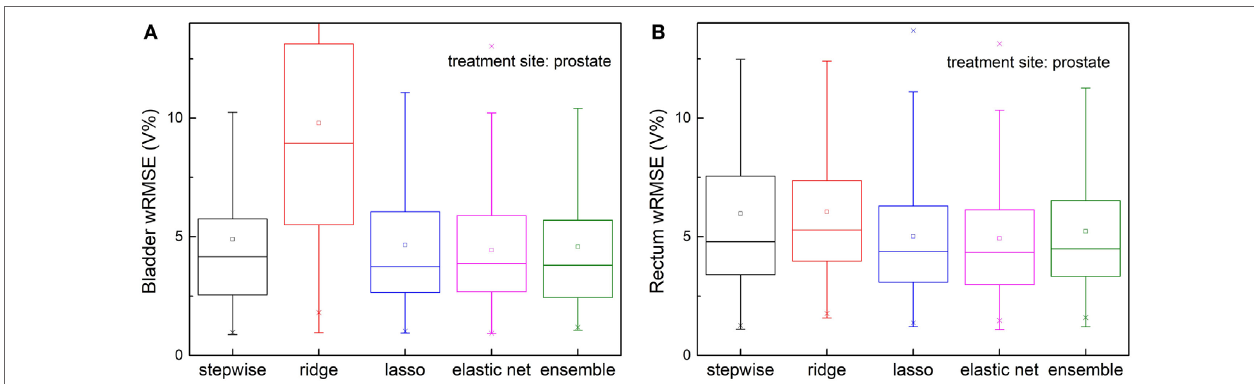
FigUre 4 | Prediction errors [weighted root mean squared error (wRMSE)] of individual regression models and the proposed ensemble model for (a) bladder (B) rectum. The training set and validation set for all the models tested are identical. Twenty prostate 1PTV cases are included in training set, and the validation set includes 146 cases. For bladder prediction, the proposed ensemble method predicts significantly better than stepwise ( p < 0.001), ridge ( p < 0.001), lasso ( p < 0.001), and elastic net ( p < 0.001); for rectum prediction, the proposed ensemble method predicts significantly better than ridge ( p < 0.001), lasso ( p < 0.001), elastic net ( p < 0.001), and stepwise ( p <